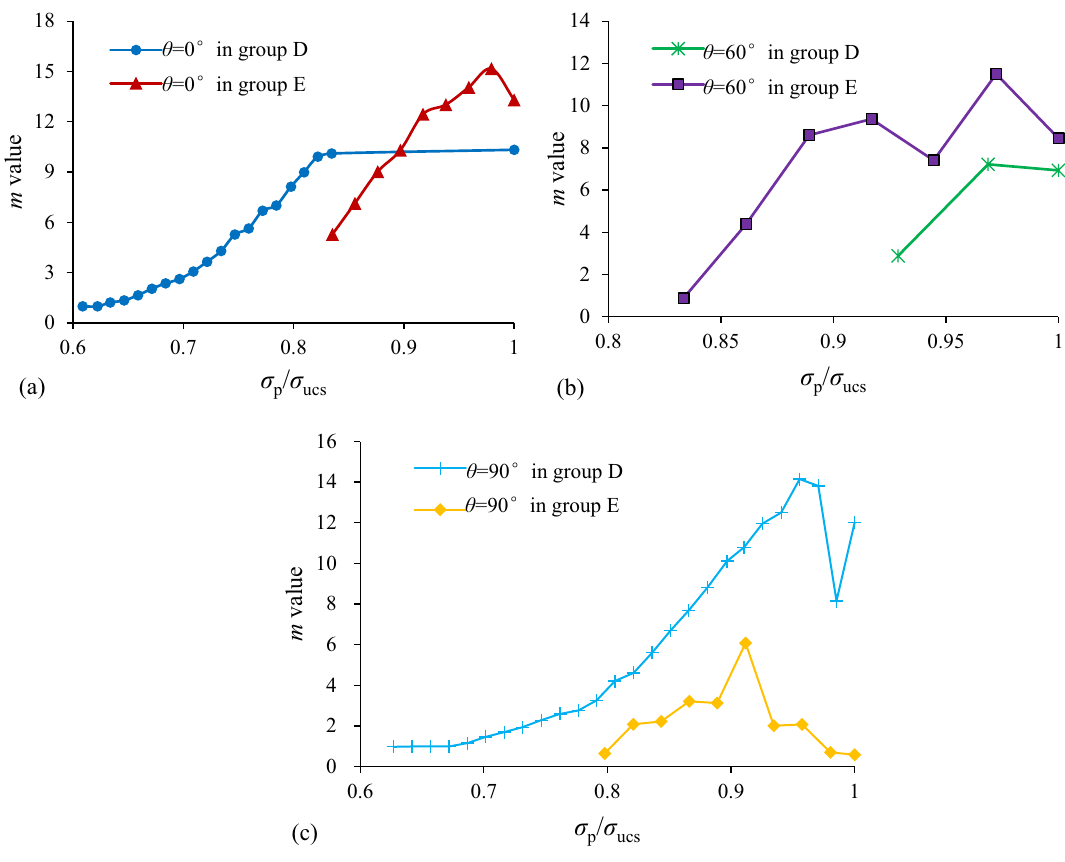
Figure 10. Evolutions of m values of shale specimens of groups D and E with different bedding dip angles as σ p / σ ucs in ascending order: ( a ) θ = 0°, ( b ) θ = 60°, and ( c ) θ =